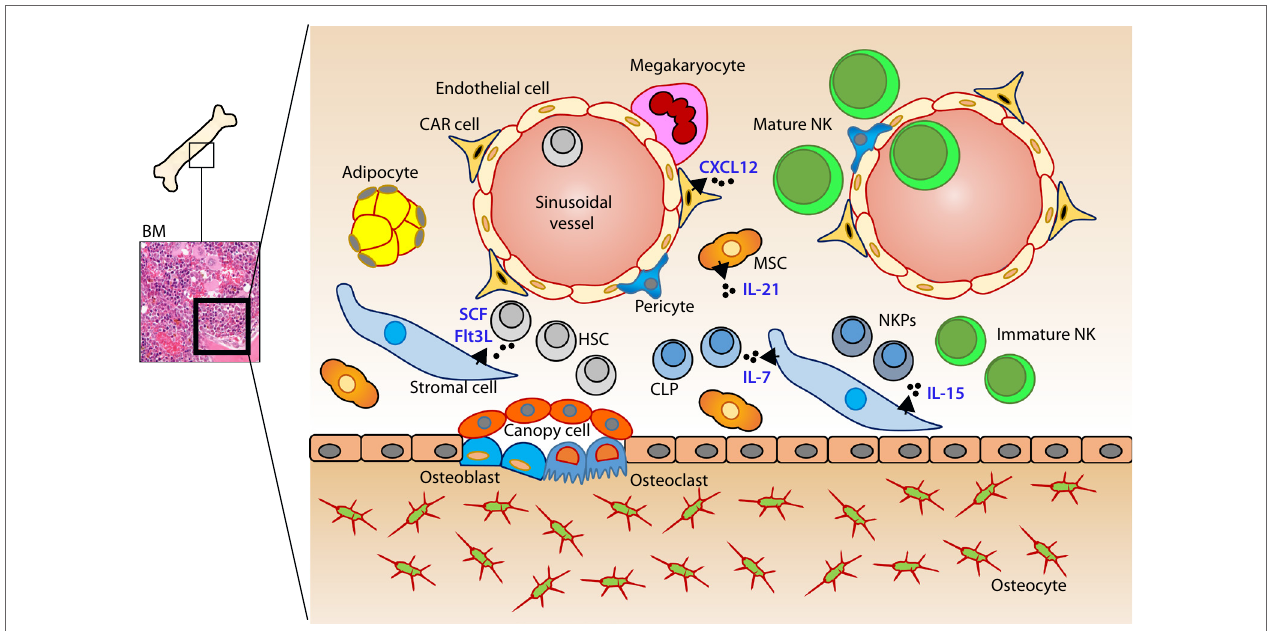
FiGURe 1 | Murine bone marrow niche where natural killer (NK) cells develop. Quiescent hematopoietic stem cells (HSCs) from a hypoxic microenvironment, within the perivascular region proximal to sinusoidal vessels, are induced by hormonal and cytokine cues. Upon unique stimulations [such as stem cell factor (SCF); Fms-like tyrosine kinase-3 ligand (Flt3L)], the self-renewing multipotent HSCs commit to becoming common lymphoid progenitors (CLPs). Non-hematopoietic stromal cells [mesenchymal stromal cells (MSCs), fibroblastic reticular cells] that produce interleukin (IL)-7 or IL-15 play pleiotropic roles in programming CLPs into distinct lymphoid lineages including NK cell progenitors (NKPs). MSCs also produce another common gamma chain receptor ( γ c R)-binding cytokine, IL-21 that may help with the expansion of the NKPs. CXCL12-abundant reticular (CAR) cells generate CXCL12, which stimulates NKPs via CXCR4 to functionally mature the NKPs or immature NK cells (iNKs) into established Mature NK (mNK) cells subsets. mNK cells traffic to secondary lymphoid organs via the sinusoidal blood vessels. Other cell types, pericytes, megakaryocytes, adipocytes, canopy cells, osteoblasts, osteoclasts, and osteocytes help form the niche and other supporting